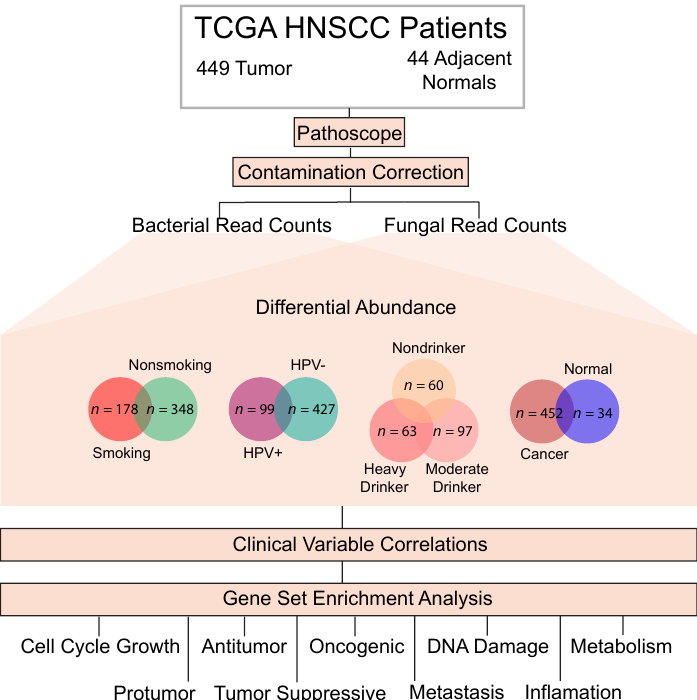
Figure 1. Schematic of project workflow. RNA sequencing data were downloaded from The Cancer Genome Atlas (TCGA) for 449 HNSCC primary tumor samples and 44 adjacent solid tissue normal samples. The PathoScope 2.0 framework was used to extract bacterial and fungal read counts from patient samples. The following four cohorts were used for all data analysis to limit the effect of the confounding variables: (1) 449 HNSCC samples and 44 adjacent normals, (2) 99 HPV+ cancer samples and 427 HPV- cancer samples, (3) 153 HPV- smoking cancer samples and 92 HPV- non- smoking cancer samples, and (4) 60 nondrinkers, 97 moderate drinkers, and 63 heavy drinkers, all